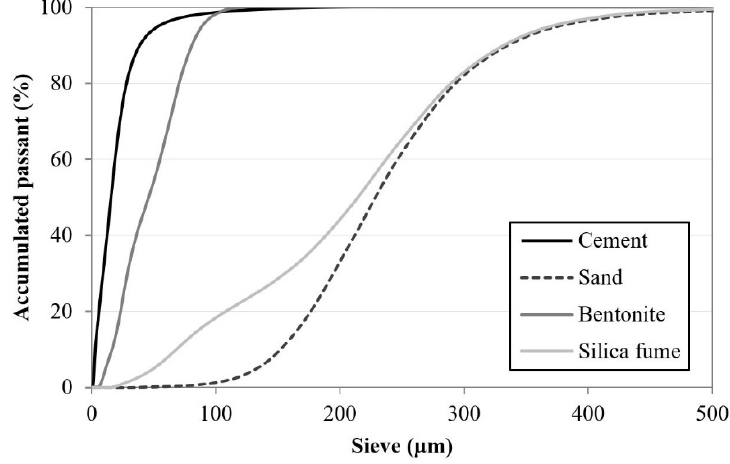
Figure 2. Gradation of the powder